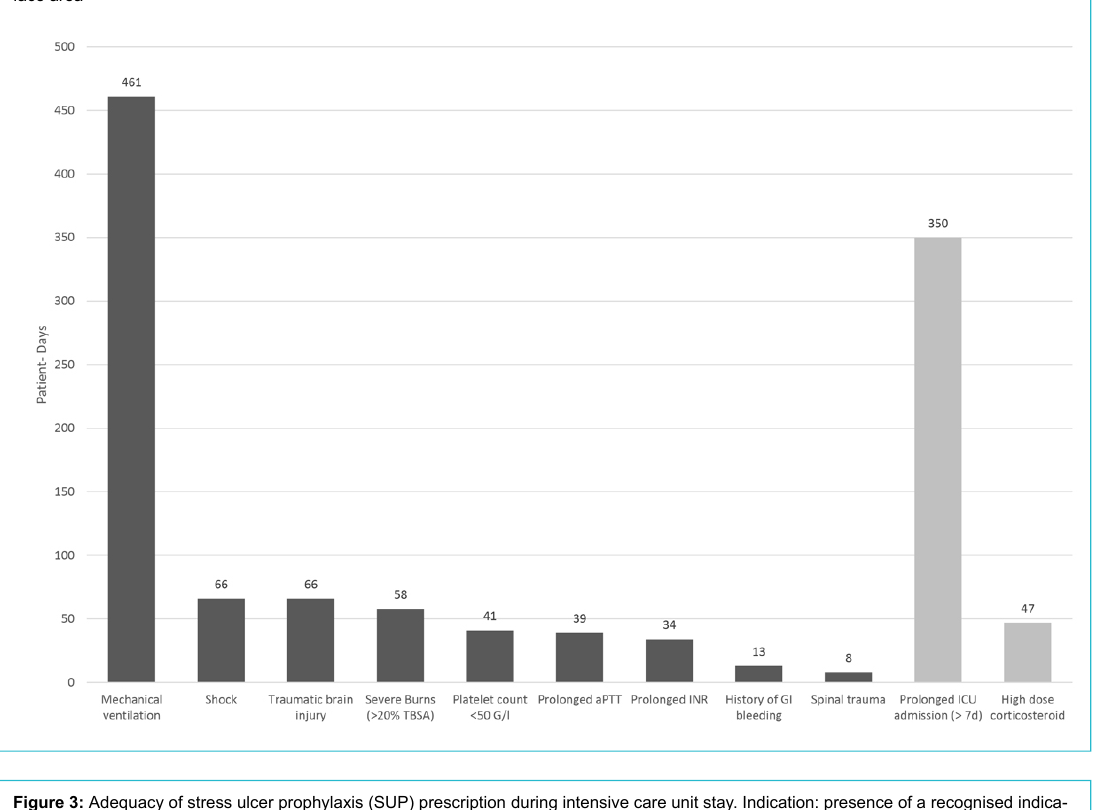
Figure 2: Criteria for stress ulcer prophylaxis (SUP) prescription in the intensive care unit. Number of patients-days during which criteria for SUP prescription were fulfilled according to our local guidelines (more than one criterion might be fulfilled in a single patient-day). aPTT = acti- vated partial thromboplastin time; GI = gastrointestinal; ICU = intensive care unit; INR = international normalised ratio; TBSA = total body sur- face area